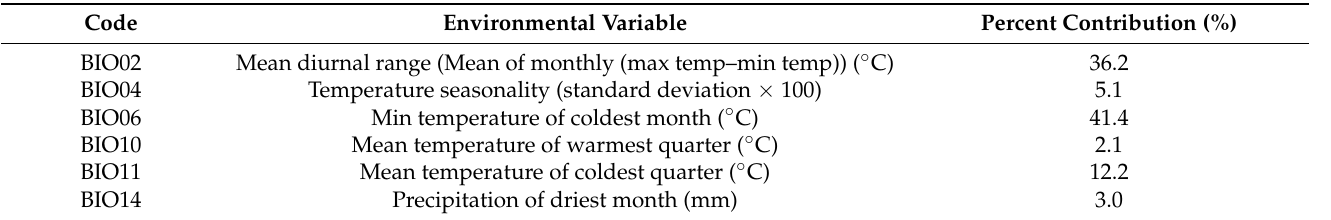
Table 1. Environmental variables and their contributions and suitable value ranges.